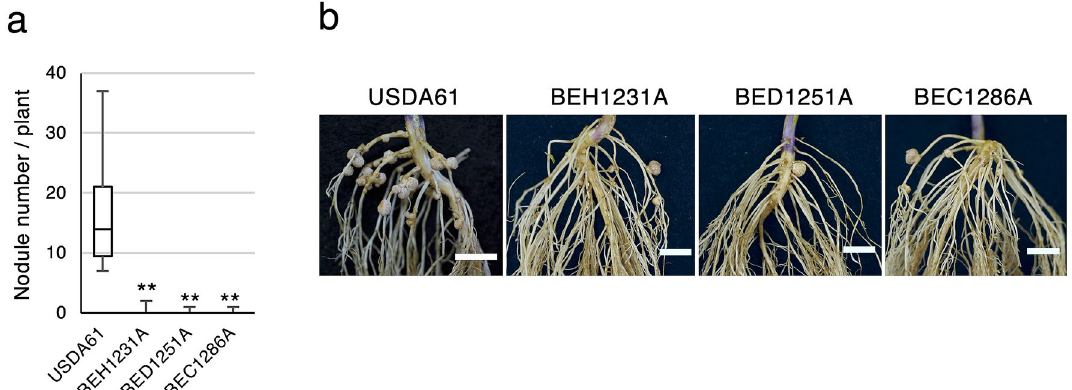
Figure 4. Nodulation of G. max cv. En1282 ( nfr1 mutant soybean) inoculated with Bel2-5 ULP1 domain mutant strains. ( a ) The number of nodules formed on En1282 inoculated with wild-type and the mutants of predicted catalytic core of Bel2-5 ULP1 at 30 dai. Values represent mean ± SD ( n = 15, from three independent inoculation tests). ** p < 0.001 by two-tailed Student t -test compared to USDA61 wild-type. ( b ) Roots of En1282 inoculated with wild-type and the mutants of predicted catalytic core of Bel2-5 ULP1 were photographed at 30 dai. Scale bars: 1 under the test conditions. Therefore, unidentified regulators or inducers may be involved in the regulation of the USDA61 tts genes. To confirm that Bel2-5 is translocated into host cells, we used an adenylate cyclase (Cya) reporter system. Here, the Bel2-5 C-terminus was fused to the calmodulin-dependent adenylate cyclase domain of Cya, and thus, if bel2-5cya was translocated into cells, cAMP synthesized by Cya due to calmodulin, which is present only in eukaryotic cells, could be detected 40 . The bel2-5cya hybrid was introduced into the WT USDA61 and BErhcJ strains to generate BECya and BErhcJCya, respectively, and cAMP levels were measured from fresh Glycine max cv. Enrei nodules inoculated with the mutants at 18 days post-inoculation (dpi) (Fig. 3c); cAMP accumulation was substantially increased in nodules infected with BECya but not BErhcJCya or USDA61 lacking cya (Fig. 3c), which confirmed that Bel2-5 was translocated into plant cells and that the T3SS machinery was essential for its translocation. The presence of an NLS motif at 788–796 aa in Bel2-5 indicated potential nuclear translocation of the protein (Fig. 2b,c; Supplementary Data 1b). To check whether Bel2-5 targets the nuclei of plant host cells, we constructed a Bel2-5 C-terminally fused with enhanced GFP (Bel2-5-eGFP) and transiently expressed it in Nicotiana bentha- miana leaves using Agrobacterium tumefaciens -mediated transformation. Confocal analysis performed 48 h after infiltration confirmed the nuclear localization of Bel2-5, as the GFP fluorescence signal colocalized specifically with the DAPI signal (a nuclear staining) in the nucleus of the cells (Fig. 3d). This result indicate that Bel2-5 is translocated into the host cell and targeted to the plant nucleus.